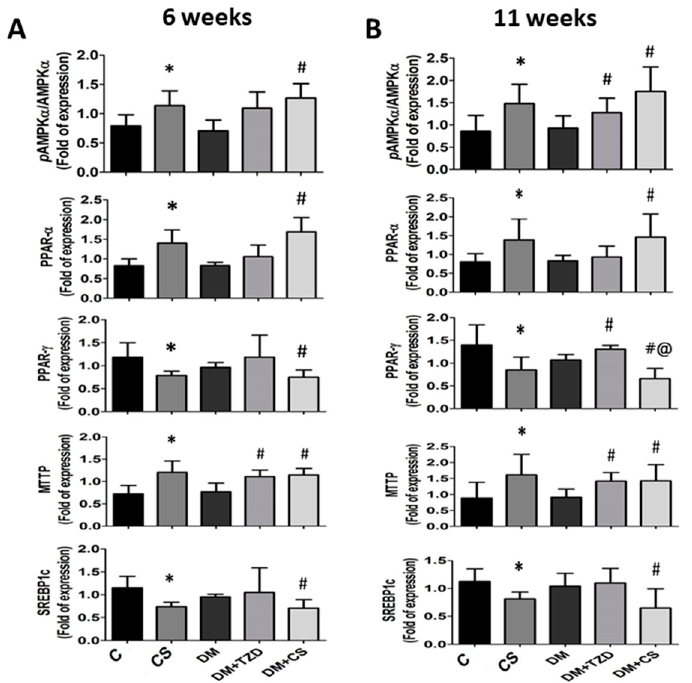
Figure 2. Effects of chitosan on metabolic signaling protein expression in the liver of diabetic rats with different feeding durations. ( A ) 6-week feeding duration; ( B ) 11-week feeding duration. The protein expression for phosphorylated AMPK, AMPK, PPAR- α , PPAR- γ , MTTP, SREBP1c, and β -actin (internal control) was determined by Western blot analysis. The densitometrical quantification is shown. Results are expressed as mean ± S.D. for each group (n = 4–6). The significant difference ( p < 0.05) were analyzed by one-way ANOVA and two-tailed Student’s t -test. *: versus C; #: versus DM; @: versus DM + TZD.